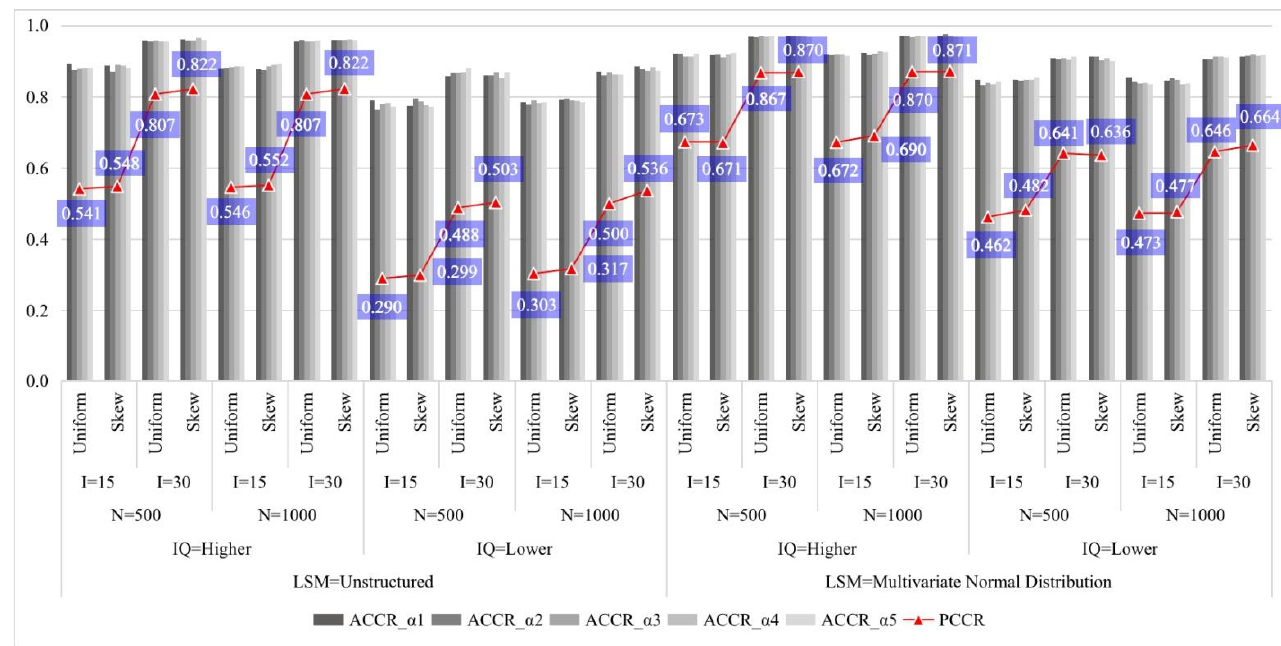
Figure 2. Summary of the recovery of attributes in simulation Study 1. Note: LSM = latent structural model; IQ = item quality; N = sample size; I = test length; ACCR = attribute correct classification rate; PCCR = attribute pattern correct classification rate.